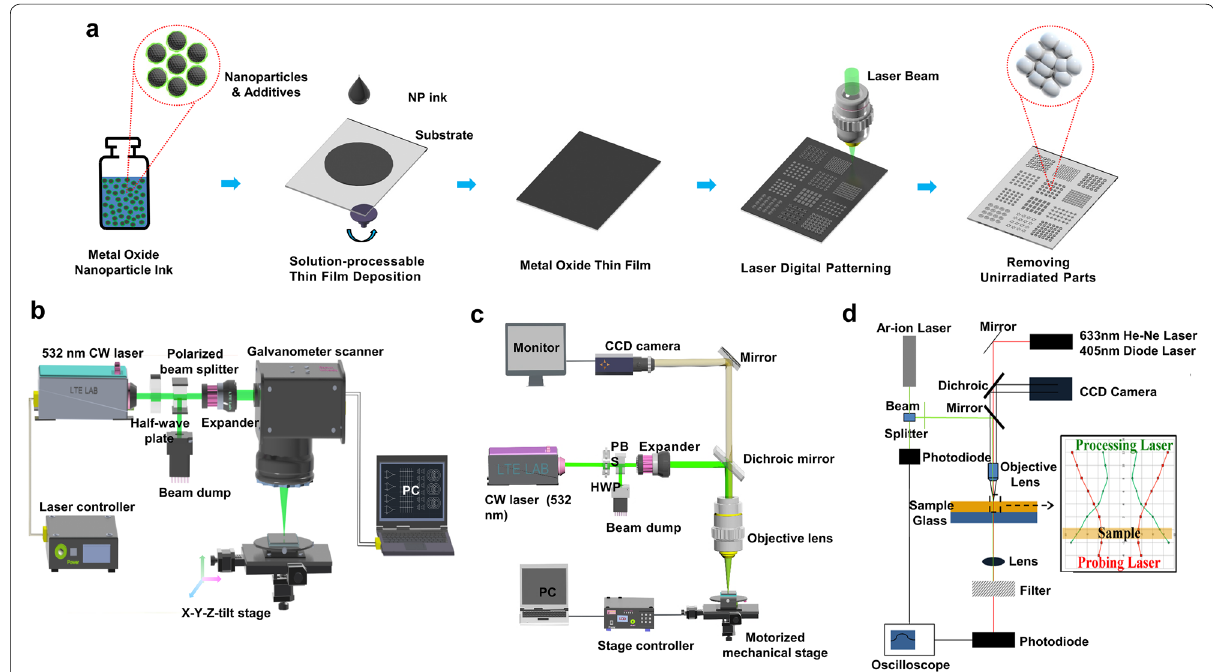
Fig. 1 a Schematic of the overall procedure of the LDP process. b Schematic of the laser setup for moving the laser beam using a galvano mirror scanner. c Schematic of the laser setup for a fixed laser beam through an objective lens (Figures b and c reproduced with permission from Ref.